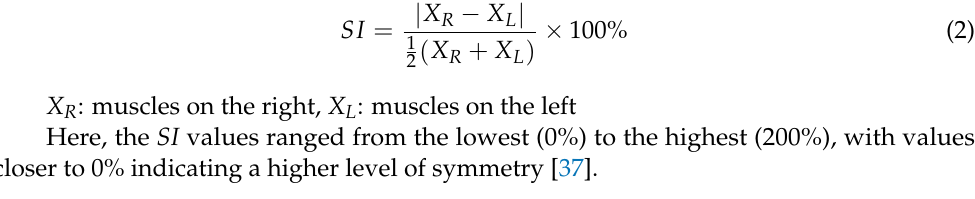
X R : muscles on the right, X L : muscles on the left Here, the SI values ranged from the lowest (0%) to the highest (200%), with values closer to 0% indicating a higher level of symmetry